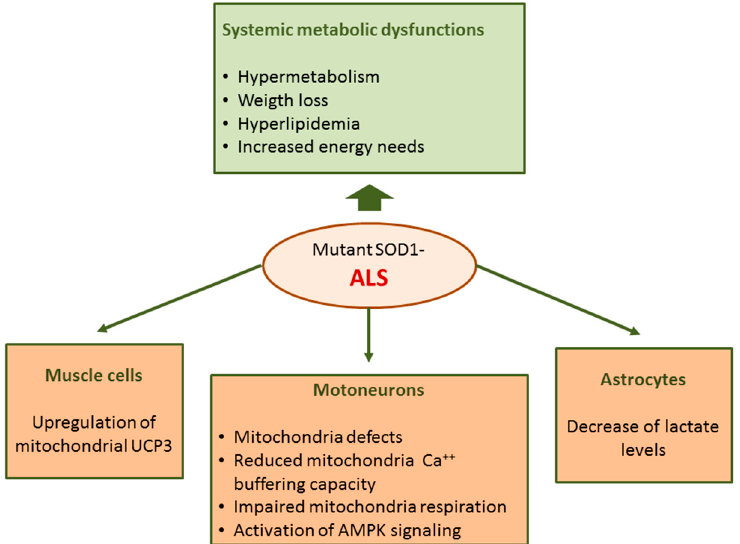
Figure 4. Metabolic dysregulation in mutant SOD1-linked familial amyotrophic lateral sclerosis (fALS).